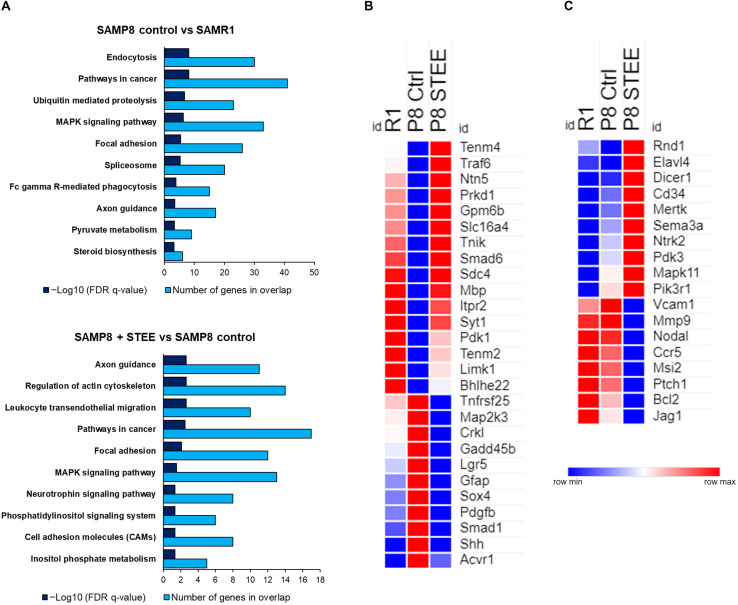
Functional analysis of DEGs between the groups. (A) Top 10 significantly enriched KEGG pathways by the DEGs between the groups (p < 0.05; modified Fisher’s exact test). Heatmaps showing relative expression intensity of genes. (B) Genes regulated in the same direction both in SAMR1 controls and STEE-fed SAMP8 compared to SAMP8 controls. (C) Genes regulated specifically in SAMP8 fed with STEE. Represented genes in heatmaps are mainly involved in neurotrophin signaling, glucose metabolism, and neurodevelopment.